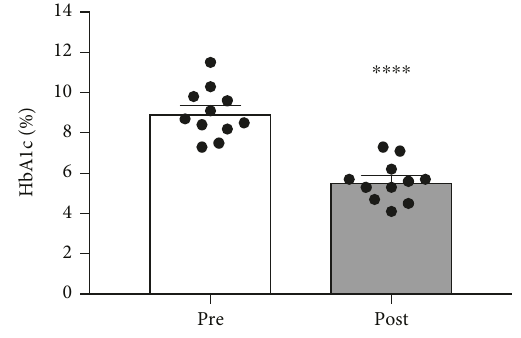
Figure 3: The e ff ect of a 90-day low-carbohydrate diet on HbA1c in women ( n = 11 ; ∗∗∗∗ p < 0 0001